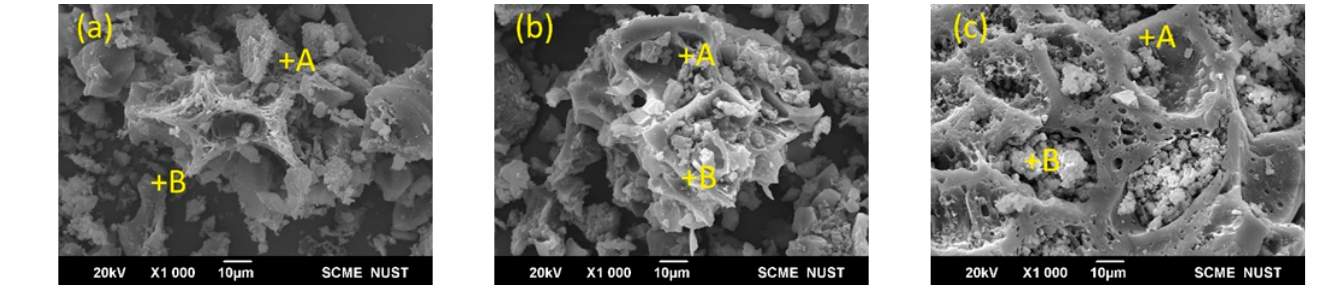
Figure 2. SEM images ( a ) peach shell biochar, ( b ) activated carbon and ( c ) 20Ca/AC-650.